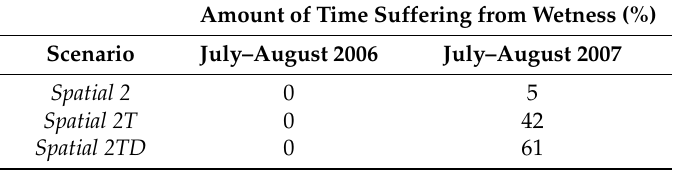
Table 2. The amount of time when at least 50% of the area suffers from wetness (WT depth < 0.3 m) during the July–August period. For scenario definitions, see Section 2.5.